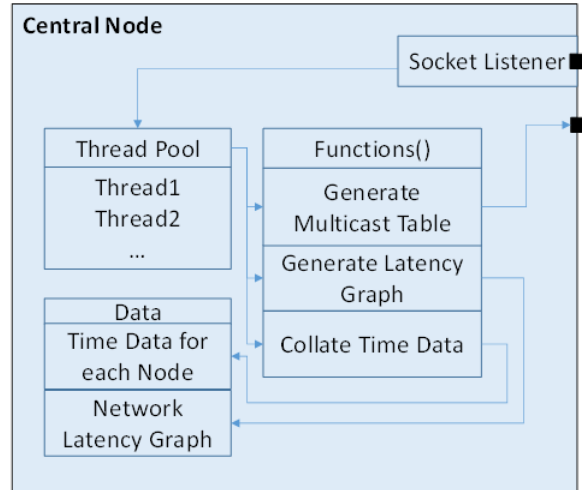
Fig. 6. Architecture of Central Node Program